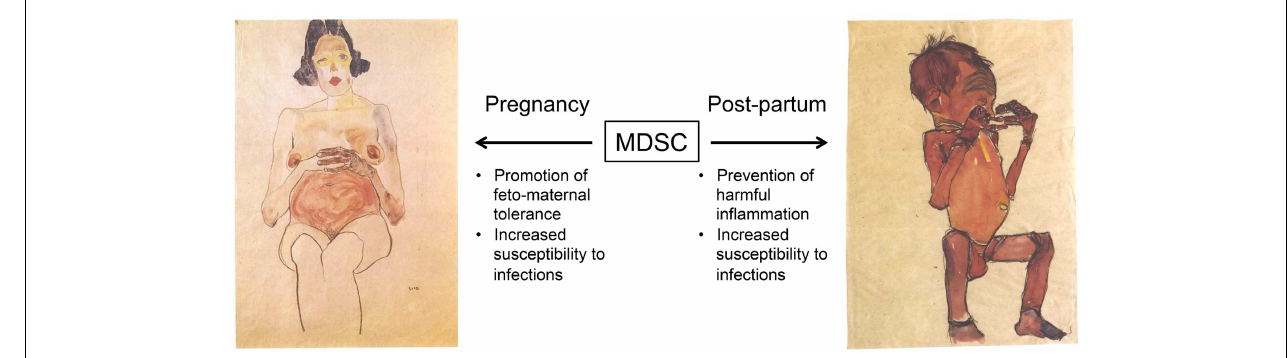
to environmental antigens. However, this may also impair the generation of protective immune responses against infections. Images by Egon Schiele (1890 – 1918), obtained throughWikimedia Commons (http://commons.wikimedia.org). Left, Red nude, pregnant (Roter akt, schwanger) 1910, private collection. Right, Newborn hiding its face with its hands (Neugeborenes die hände vor das gesicht haltend) 1910, Leopold